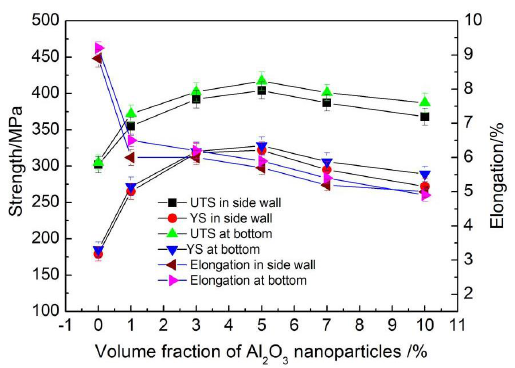
Figure 11. Influence of volume fraction of nano-sized Al 2 O 3 on mechanical properties of rheoformed 2024 aluminum matrix composite component reinforced by 5 vol % Al 2 O 3 nanoparticles at 620 °C for 25 min stirring time.